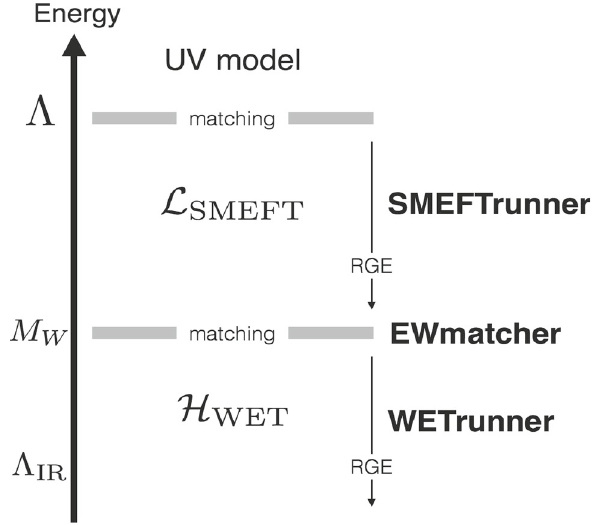
Fig. 2 Functionality of DsixTools